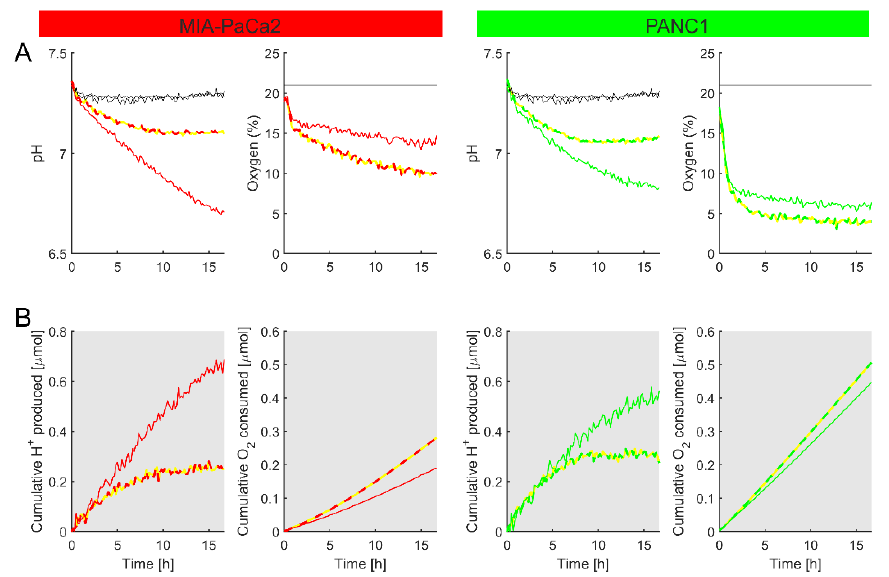
Figure 7. Using the method to study the response to a change in metabolic substrate. ( A ) Time courses of pH and O 2 measured for MIA-PaCa2 (red) and PANC1 (green) plated at 70k cells per well. Thick dashed lines denote media containing galactose (25 mM) in place of glucose. Media contained 20 mM HEPES, 25 mM glucose or galactose, 25 mM NaCl and was supplemented with 10% FBS, 1% penicillin – streptomycin mixture, 1% GlutaMAX, and 1% sodium pyruvate. ( B ) The cumulative H + production and O 2 consumption, calculated using Equations (7) and (8). Plots represent a mean of 3 biological repeats.